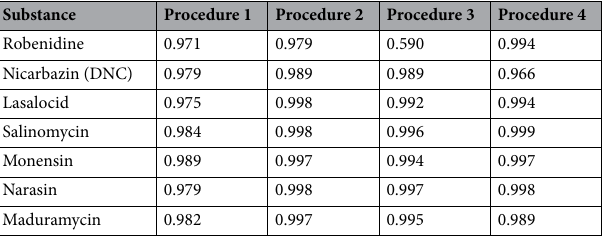
Table 3. Average determination coefficients (R 2 ) of calibration curves of coccidiostats in feed